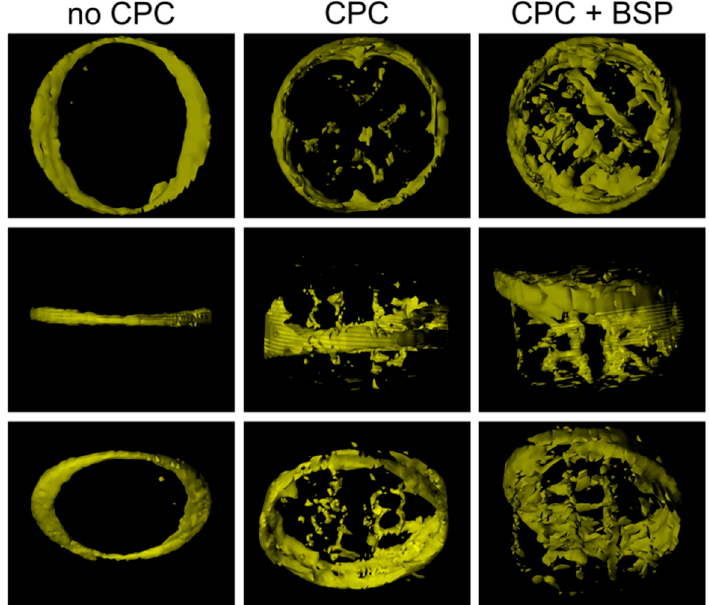
Figure 5. Three-dimensional view of newly formed bone within the region of interest (ROI) from the top view (upper row), the lateral view (middle row), and the oblique view (lower row). Bone formation can be expressed as a bone fraction or bone volume/total volume